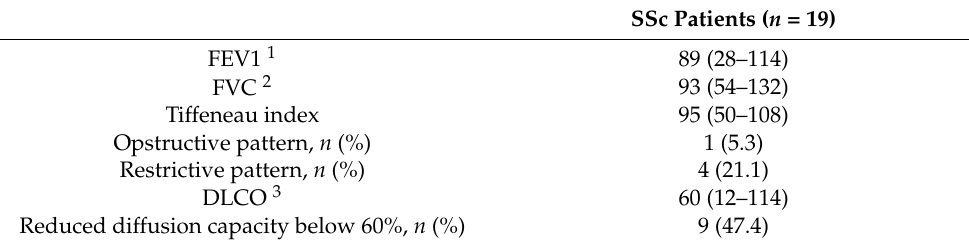
Table 2. Spirometric characteristics.